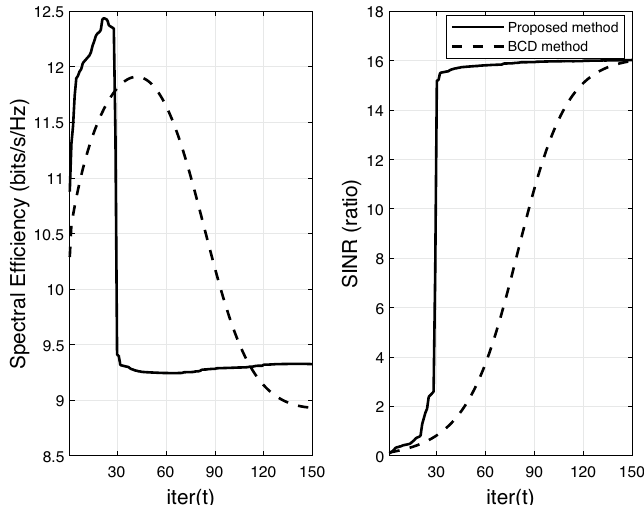
Fig. 4 The convergence behaviors of the CADMM when N t = 64 , N RF t = 16 , N cr = 4 , U = 4 and N rr = 32 , 4 N RF r =